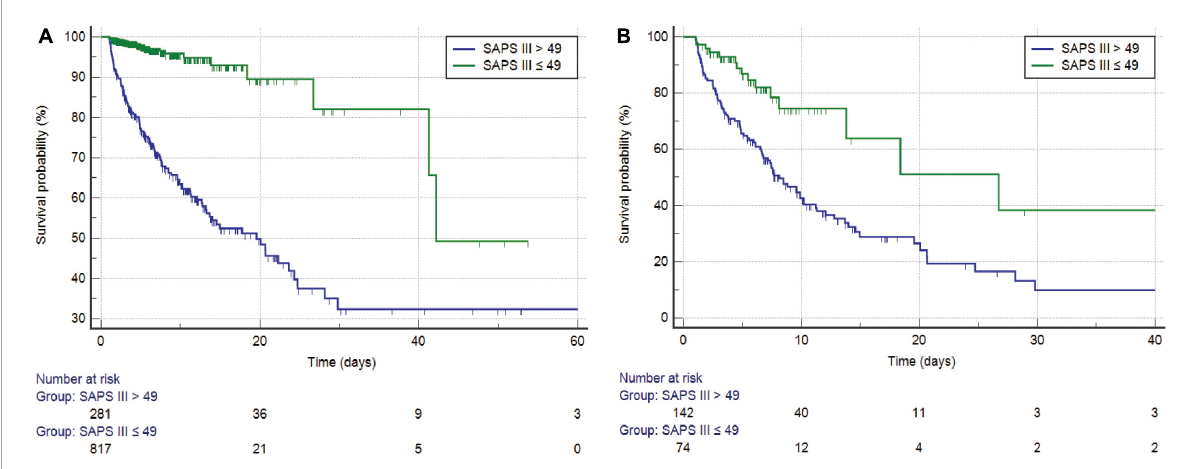
FIGURE3 (A) Kaplan–Meier survival curves of SAPS III for the study cohort before PSM (log-rank P < 0.0001). (B) Kaplan–Meier survival curves of SAPS III for the study cohort after PSM (log-rank P < 0.0001). SAPS, simplified acute physiology score; PSM, propensity score matching.